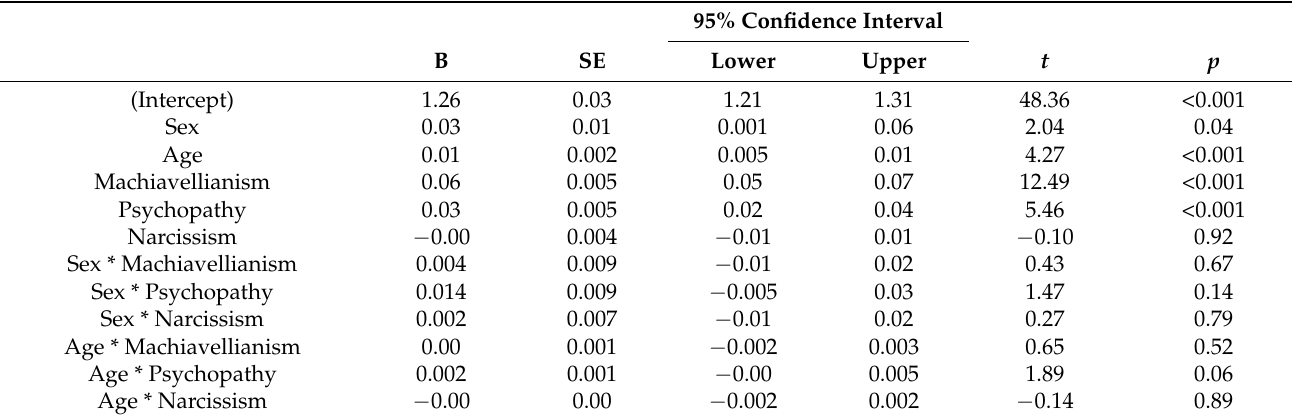
Table 7. Risky sexting: parameter estimates of fixed effects.